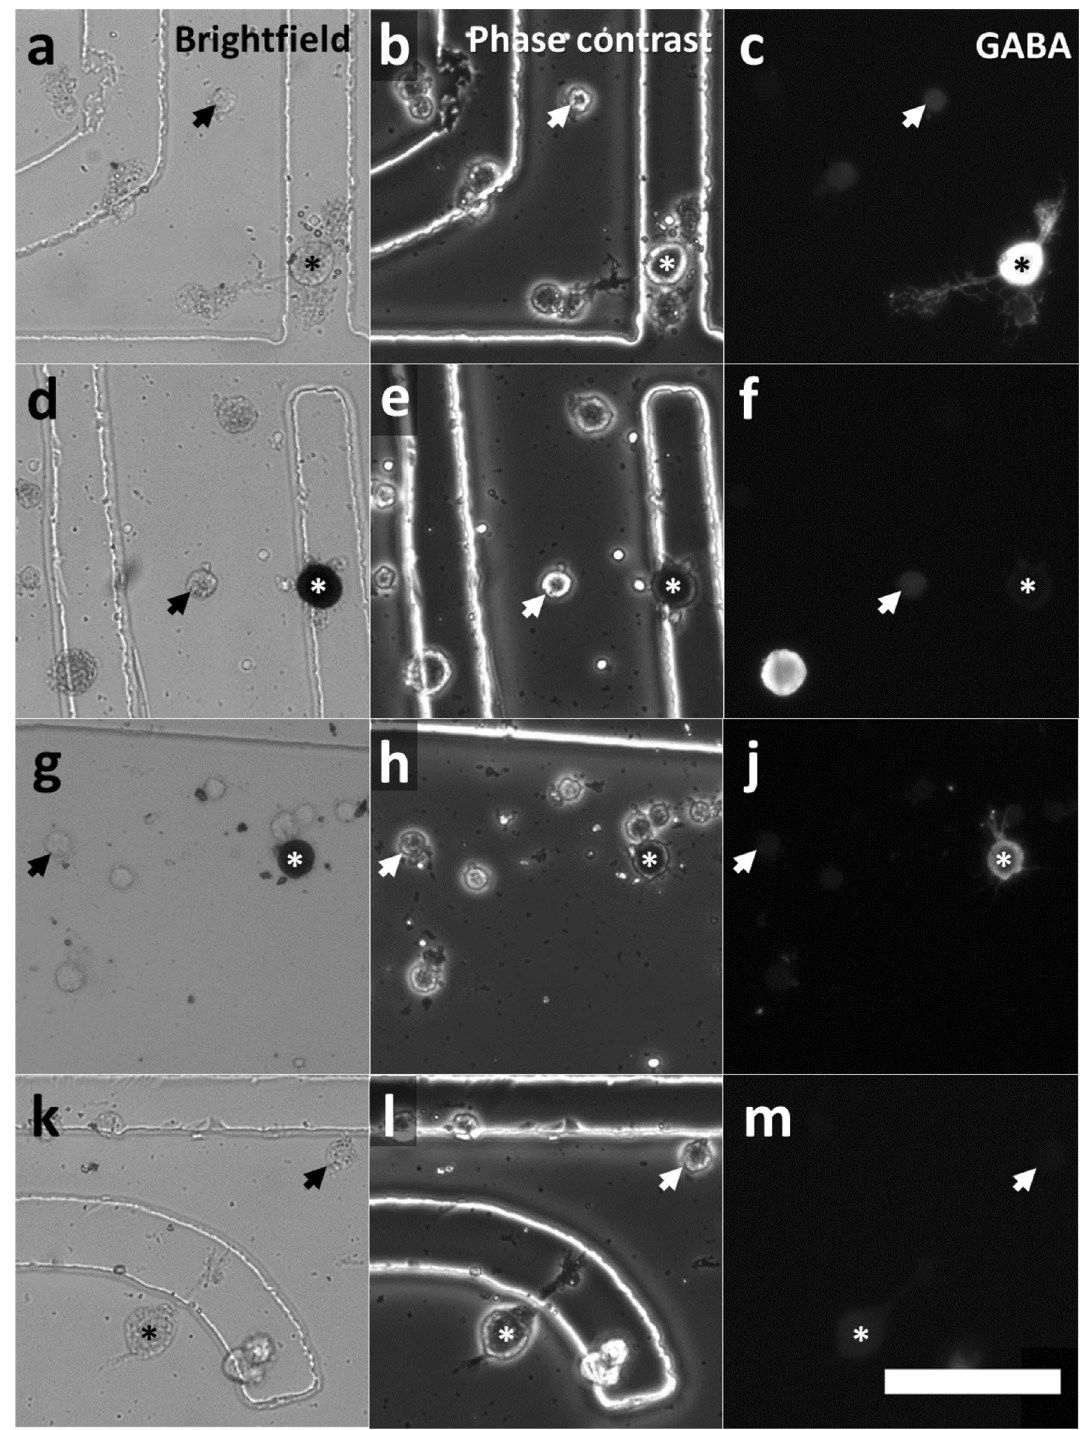
Figure 2. Cellular phenotypes of cultured antennal lobe neurons. Adherent neurons of different soma diameter were grown in petri dishes that contained a numbered location grid for proper cell identification after calcium imaging. Small neurons with soma diameter of about 15 µm are considered as PN (arrows), whereas large neurons of soma diameters above 19.61 µm are regarded to be LN (asterisk). NADPHd activity and GABA-IR was detected in large neurons. LN were classified into four types: exclusively GABAergic ( a–c ); NADPHd positive ( d – f ); GABA-IR and NADPHd positive ( g–j ); LN with no determined (ND) transmitter ( k–m ). Note that LN are generally larger in diameter, but not homogenous in size. Interneurons showing GABA-IR are common, but not morphologically distinct from other non GABA local neurons. LN expressing nitric oxide synthase were detected using NADPHd staining as marker ( d , g ). NADPHd staining tends to quench the fluorescence of GABA-IR local neurons ( j ). Large unlabeled LN showing neither NADPHd activity nor GABA-IR ( k-m asterisk). Scalebar = 100